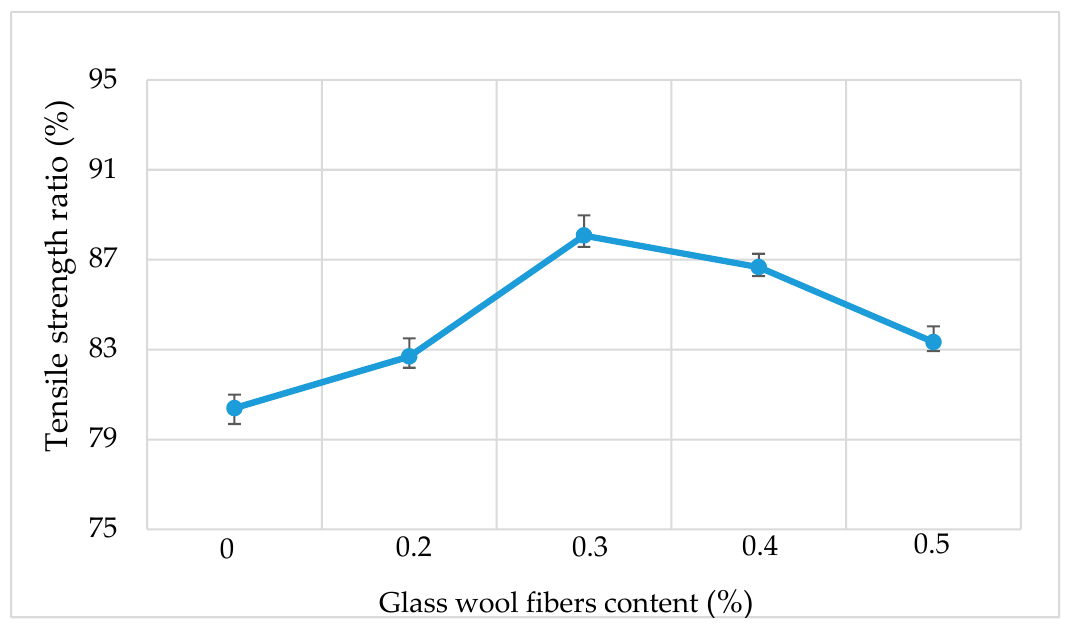
Figure 10. Tensile strength ratio results .